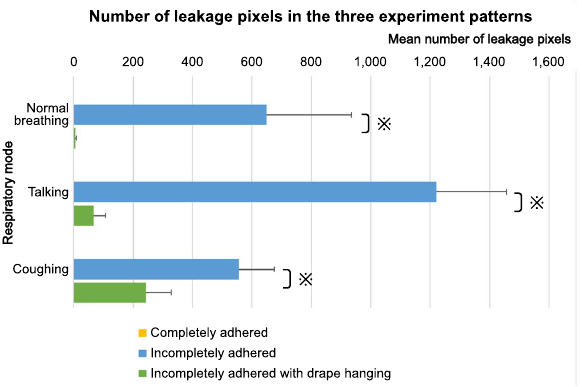
Figure 1. The mean number of leakage pixels corresponding to the three experiment patterns. The asterisks represent significant differences ( p <